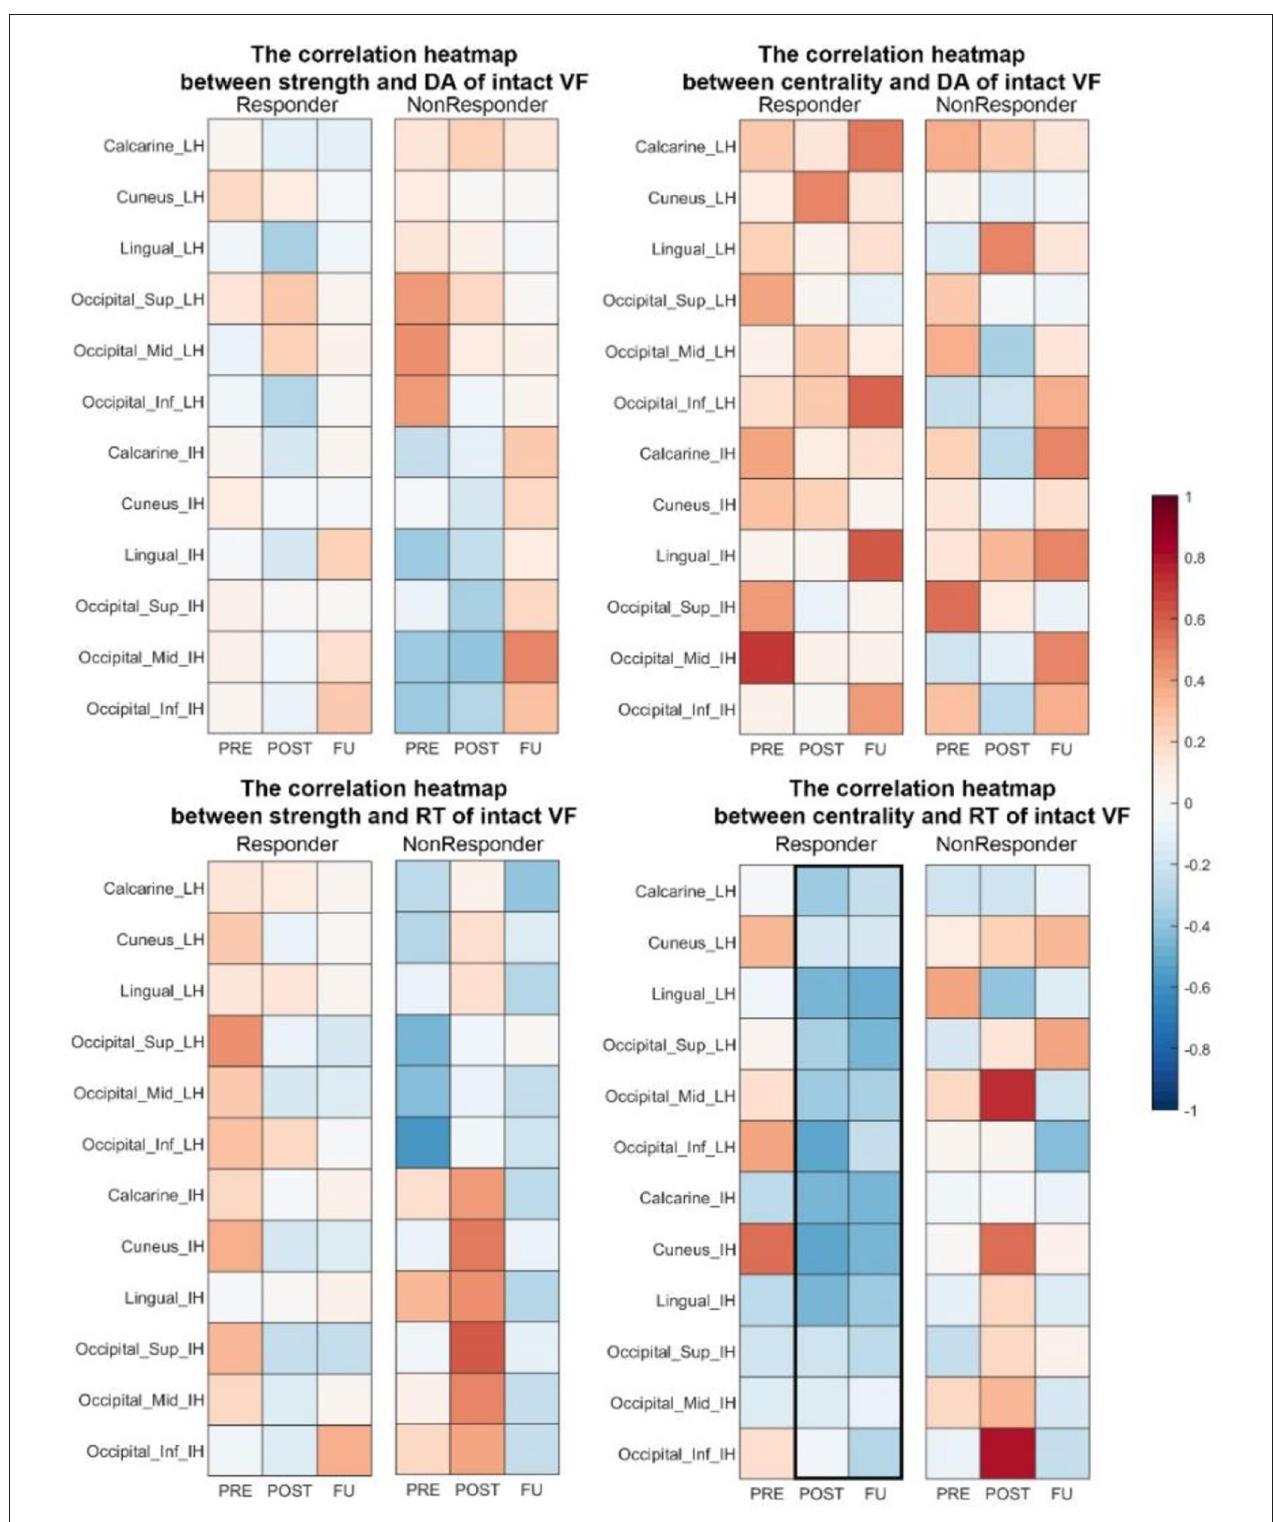
FIGURE 7 | Correlation heat map between brain network measures (strength and centrality) and visual performance in responders. At POST and FU, there was a trend of faster RT being associated with higher centrality in both hemispheres. DA, detection accuracy; VF, visual field; RT, reaction time.